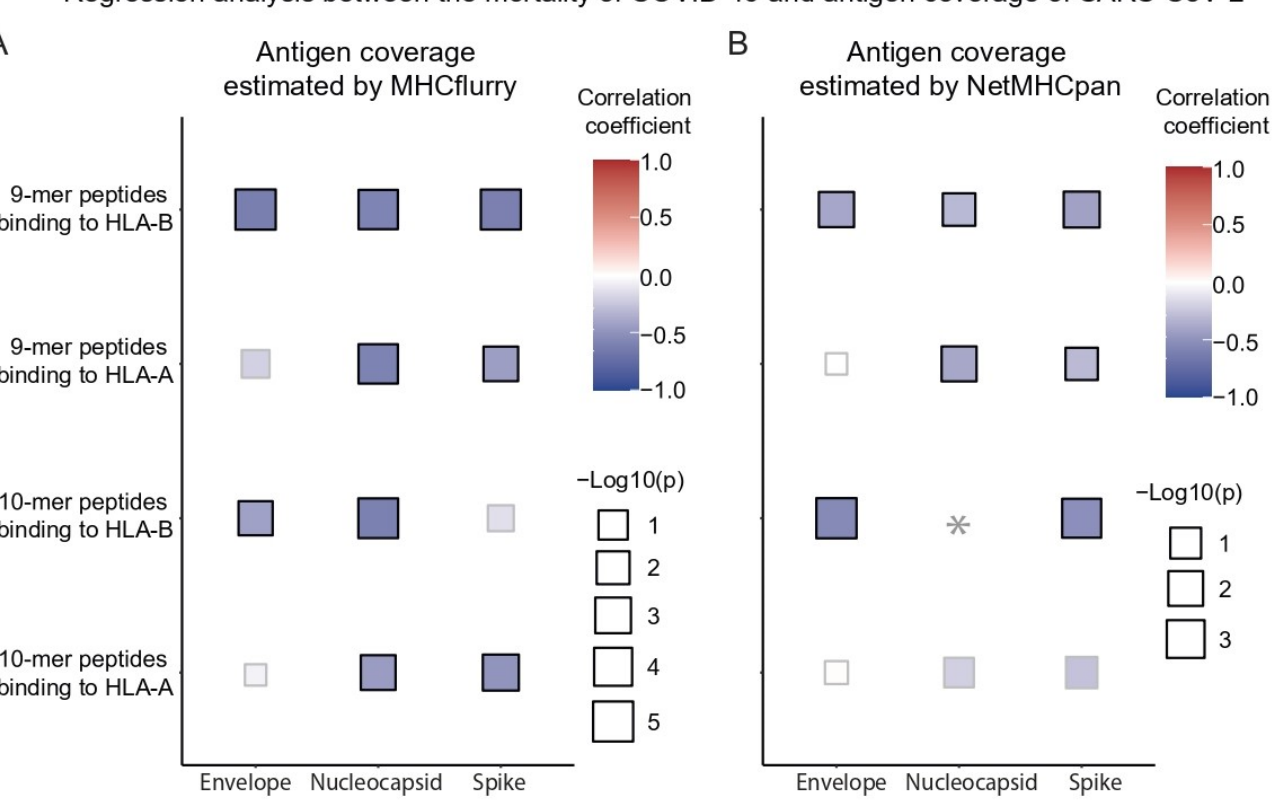
Figure 3. The p value and correlation coefficient of linear regression analysis between the mortality of COVID-19 and the antigen coverage of SARS-CoV-2 derived from envelope, nucleocapsid, and spike domains. The bold border indicates p value ≤ 0.05. The antigen coverage was estimated by MHCflurry ( A ) and NetMHCpan ( B ). The asterisk indicates the case that no peptides were predicted to be presented by any HLAs.